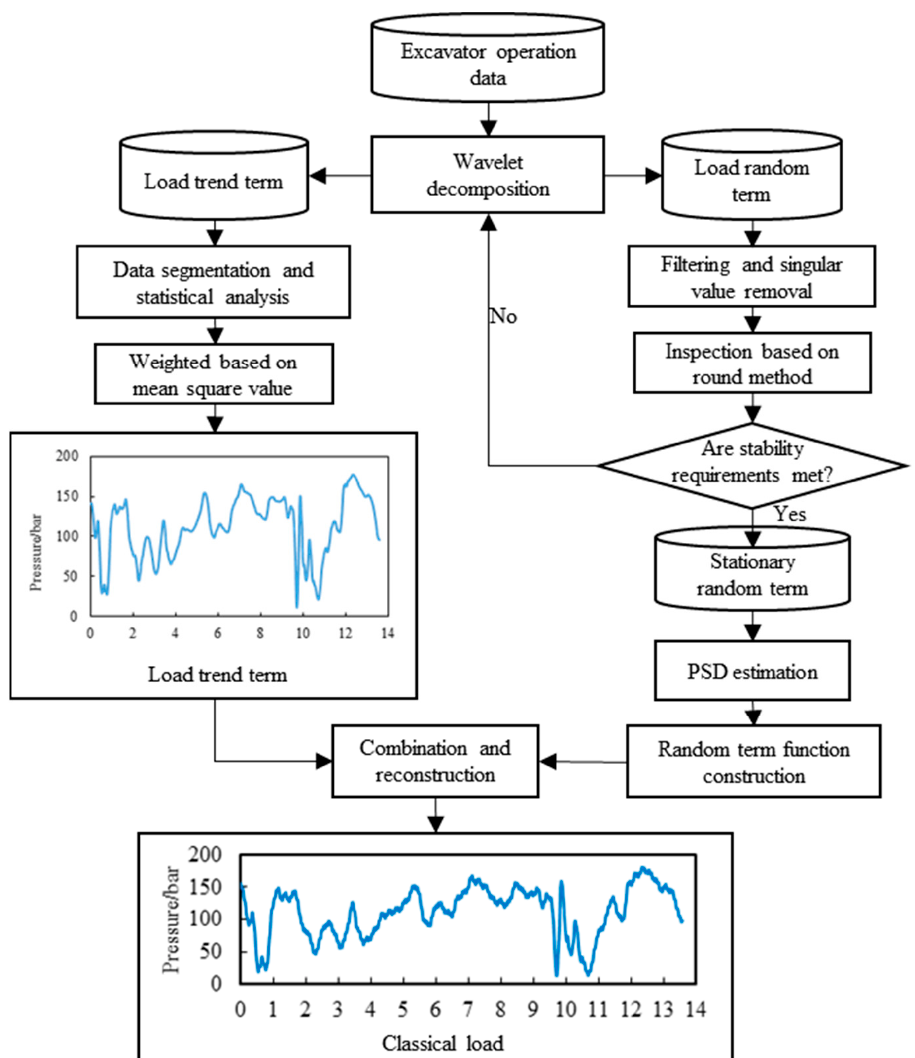
Figure 13. The typical working condition load reconstruction.